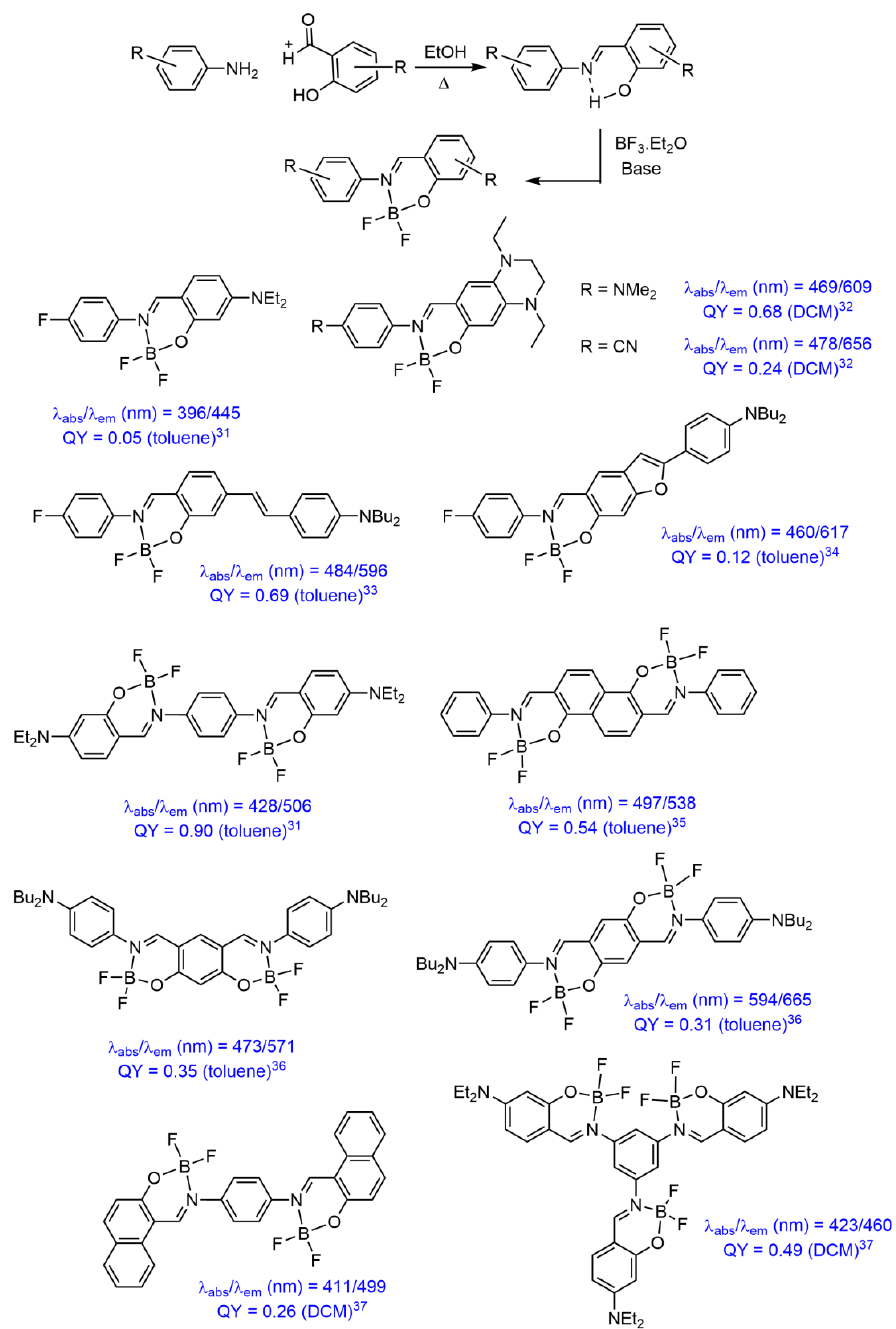
Figure 2. Synthesis and reported examples of Boranil structures [31–37].